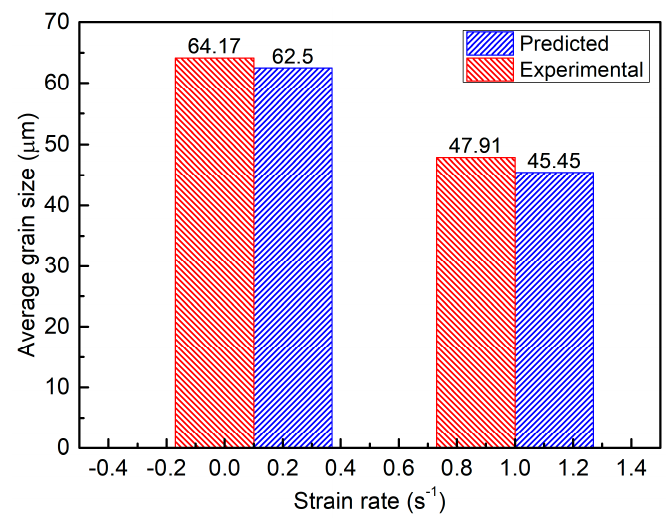
Figure 12. Comparison of the average grain size obtained from the tests and cellular automaton (CA) results at a temperature of 450 ◦ C and strain rates of 0.1 and 1 s − 1 .